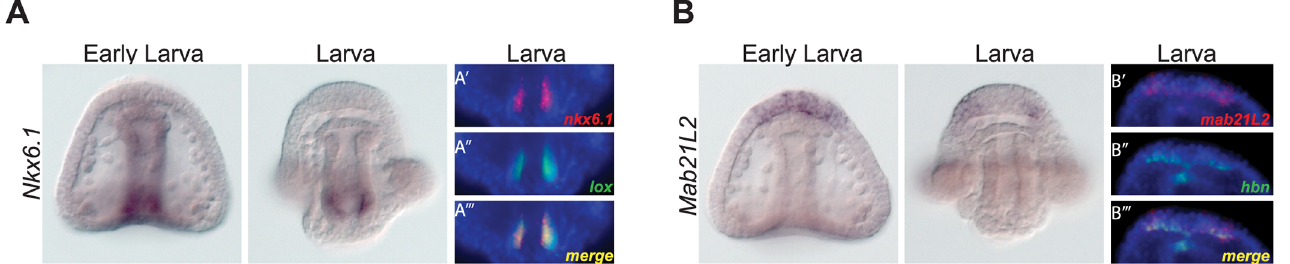
Fig 6. Cross-species transcriptome comparison reveals novel candidates for planktotrophic development. (A) Whole mount in situ hybridization reveals expression of Nkx6 . 1 is restricted to the endoderm in the early larva and to the hindgut in the larva in L . variegatus . (A ’– A ”‘ ) Double fluorescent in situ hybridization shows that Nkx6 . 1 and hindgut marker Lox colocalize in the hindgut of L . variegatus larvae. (B) Whole mount in situ hybridization reveals expression of Mab21l2 is first restricted to the apical plate and later to two lateral patches in the anterior neurogenic ectoderm in L . variegatus larvae. (B ’– B ”‘ ) Double fluorescent in situ hybridization reveals that Mab21l2 and anterior neurogenic ectoderm marker Hbn colocalize in the anterior neurogenic ectoderm of L . variegatus larvae.